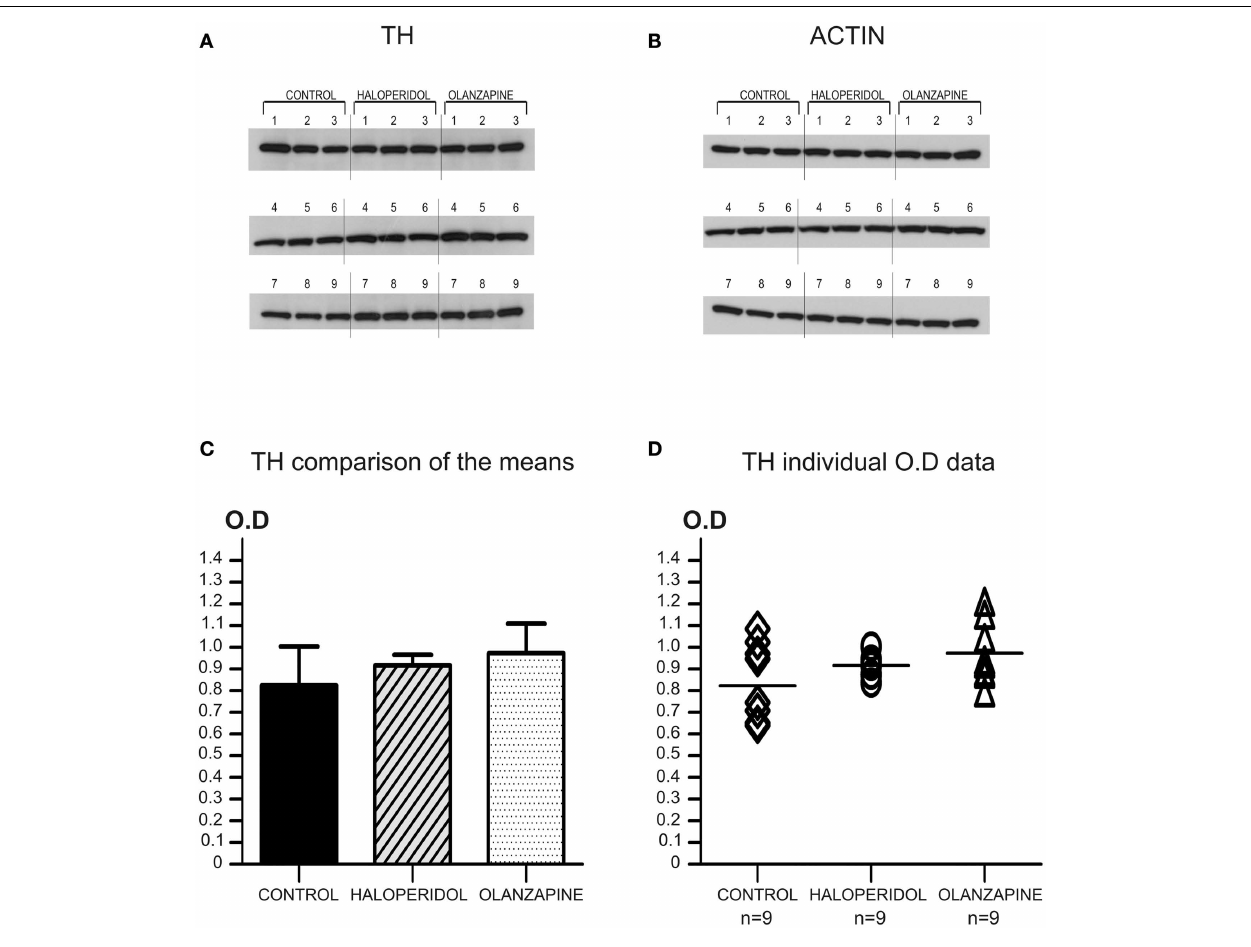
the detection of actin protein. (C) Comparison of the mean OD forTH protein levels showed no significant differences among the three groups ( P = 0.41; OD mean ± SD: control = 0.824 ± 0.181, haloperidol = 0.917 ± 0.049, olanzapine = 0.973 ± 0.136). (D) Scatter plot graph showing the individualTH protein OD values for the three groups.The horizontal bar in the scatter plot indicates the mean OD value for each